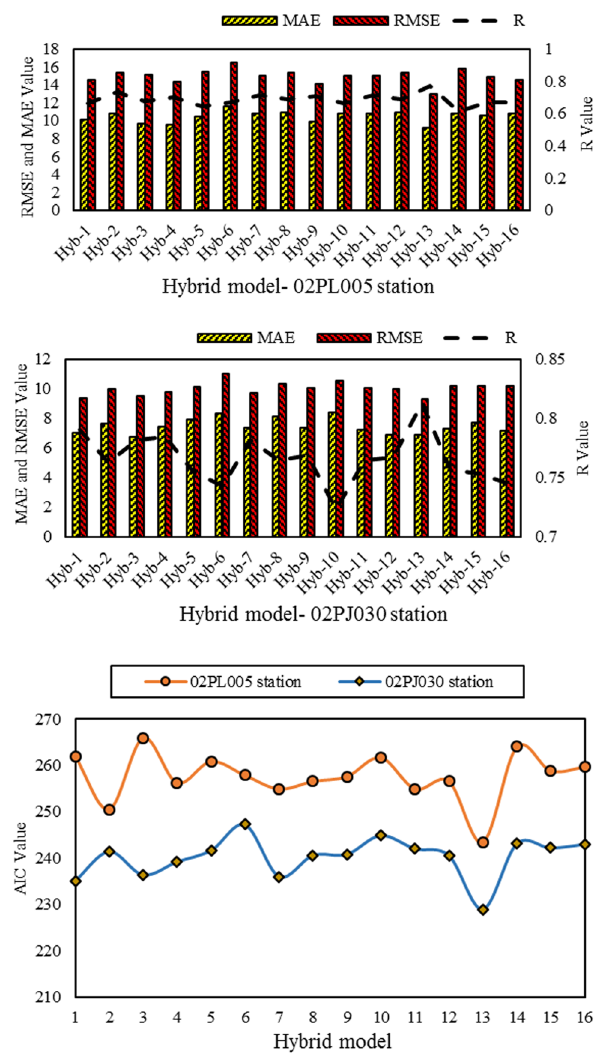
Fig. 7 Results of mathematic metrics including MAE, RMSE, R and AIC for determining the best hybrid models and for 02PL005 and 02PJ030 stations in the study